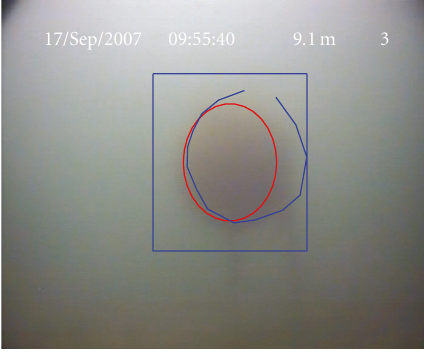
Figure 10: Segmentation of a circular mine in basin. C good = 0 . 64 and C false = 0.